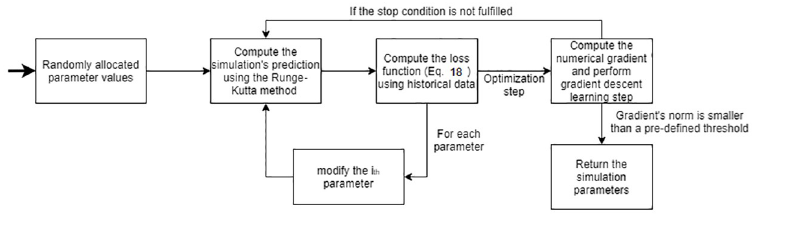
Fig 6. A schematic view of the fitting